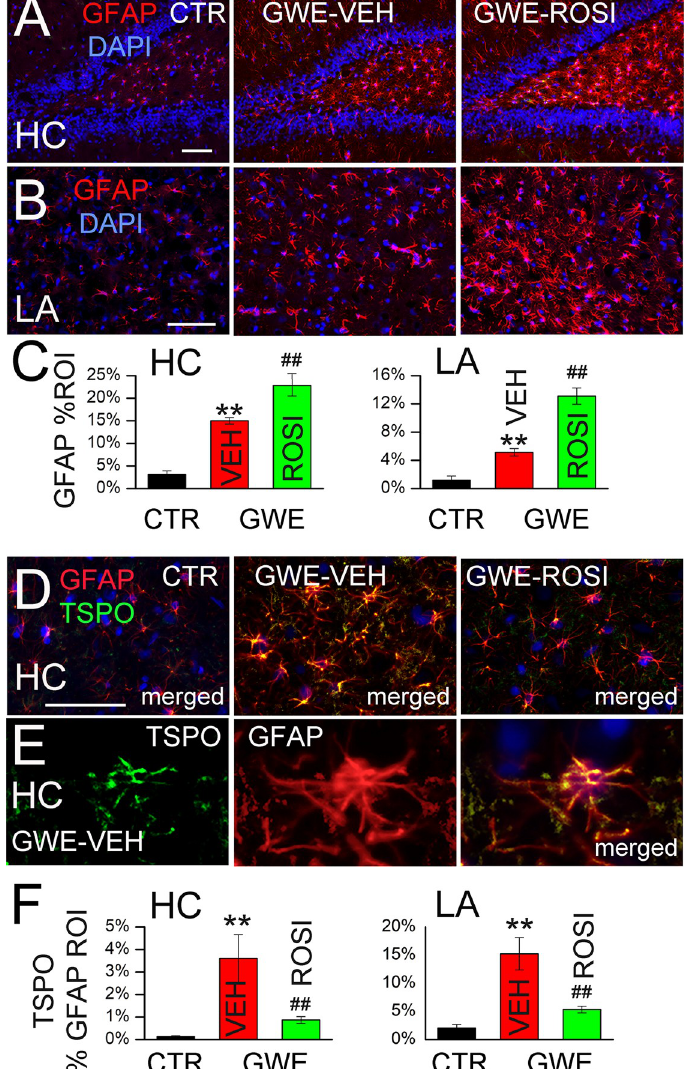
Fig 5. Astrocytosis following 33-day GWE. A,B: Immunolabeling for GFAP in hippocampus (HC) and lateral amygdala (LA) in na ï ve (CTR), GWE-VEH and GWE-ROSI rats; nuclear staining with DAPI (blue) is also shown; bars , 100 μ m. C: Quantification of GFAP in the two brain regions for the three groups, as indicated; 5 rats per group; �� , P < 0.01, compared to na ï ve; ##, P < 0.01, compared to GWE-VEH. D: Co-immunolabeling for GFAP and TSPO in hippocampus in na ï ve (CTR), GWE-VEH and GWE-ROSI rats; nuclear staining with DAPI (blue) is also shown. E: High magnification image of a cell co-immunolabeled for GFAP and TSPO, showing TSPO within the GFAP-positive cell. F: Quantification of TSPO within the GFAP-defined ROI in the two brain regions (HC and LA) for the three groups, as indicated; 3–5 rats per group.